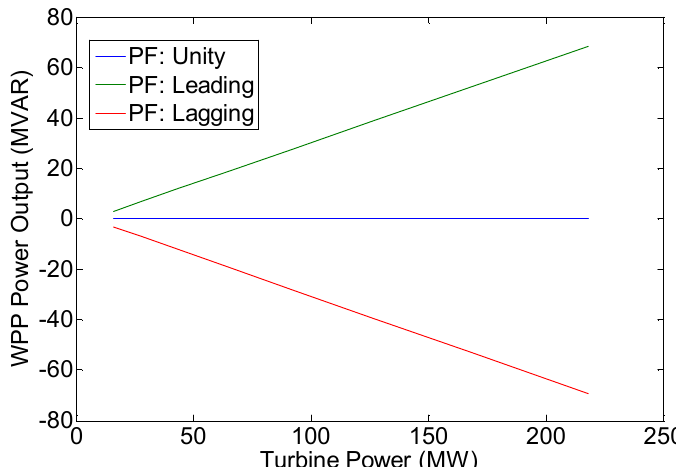
Figure 9. Variation of WPP reactive power output ( Q g ).